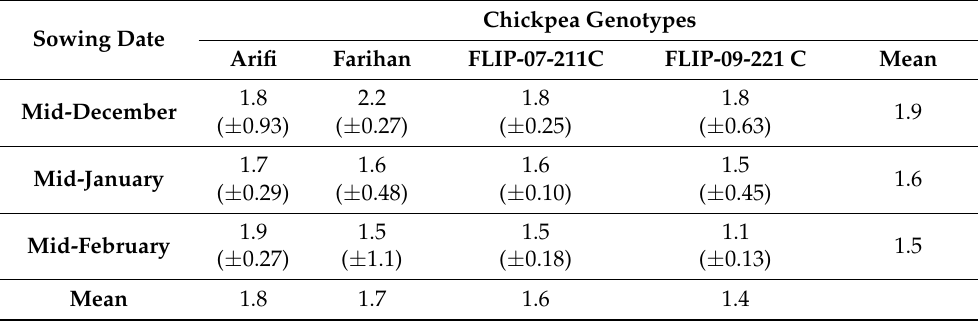
Table 6. Effects of sowing date on mean seed yield of chickpea genotypes (t/ha), 2017–2018 crop- ping